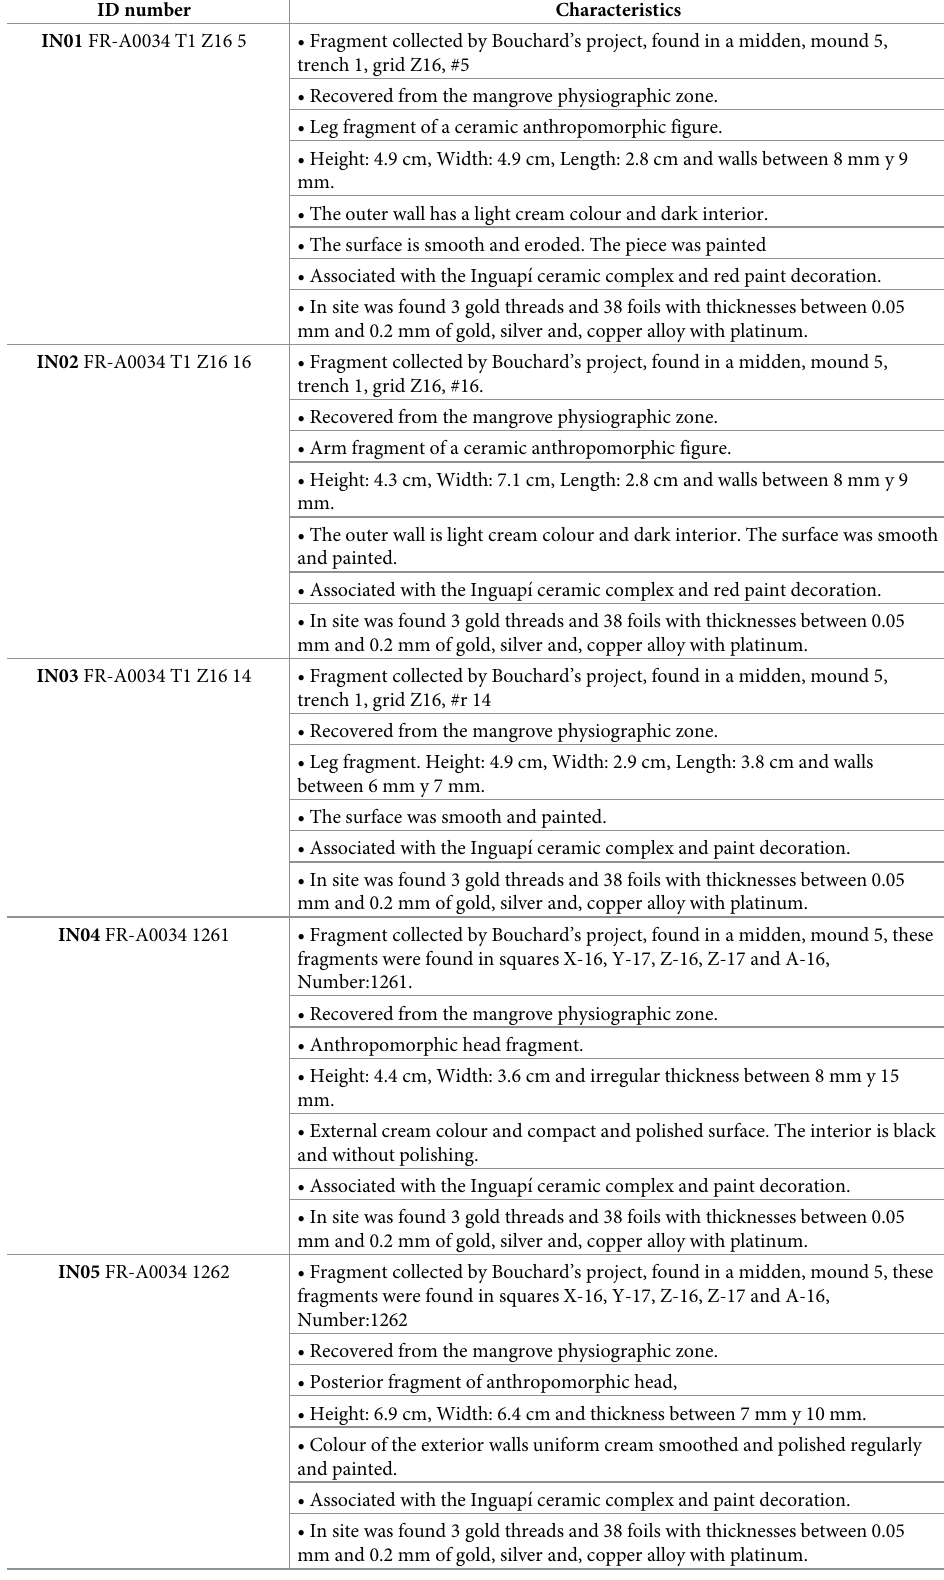
Table 1. Identification and general characteristics of the analyzed